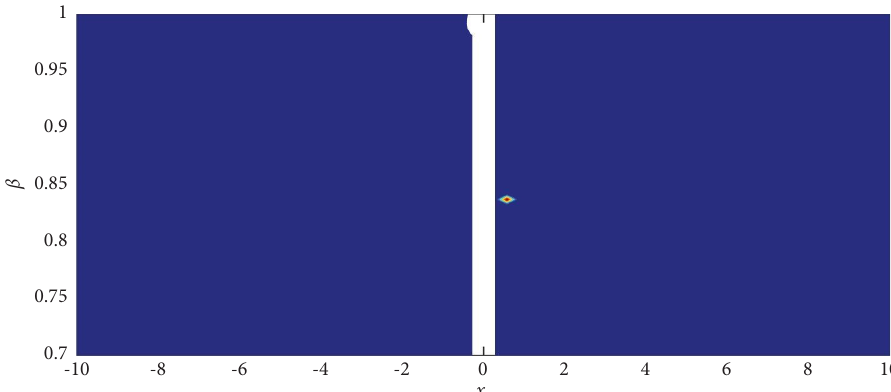
Figure 6: Convergence planes of second-order NR on f